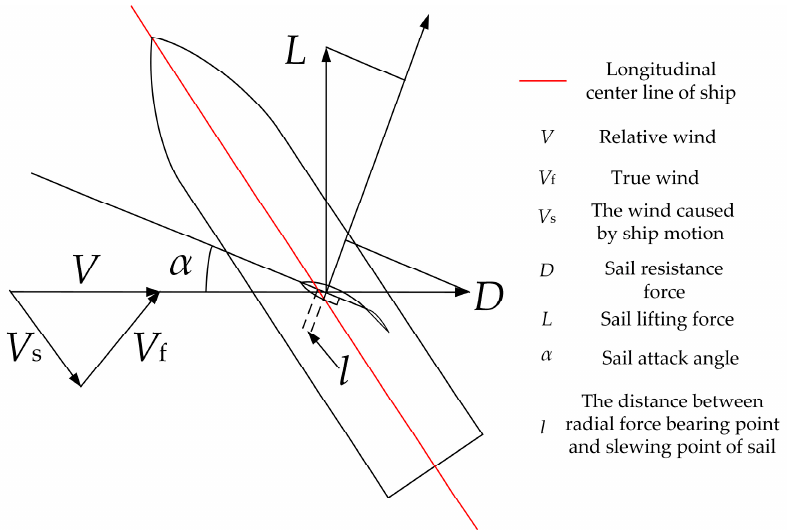
Figure 8. Sail force analysis diagram.